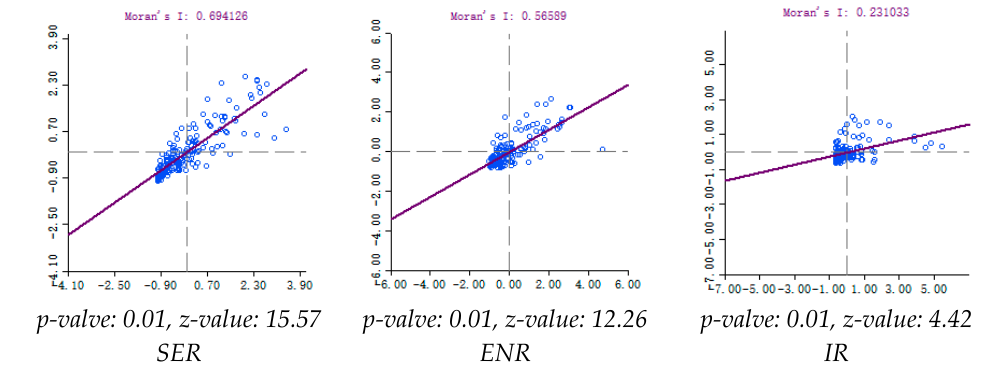
Figure 4. Moran scatterplots of non-grain production rates in four categories.